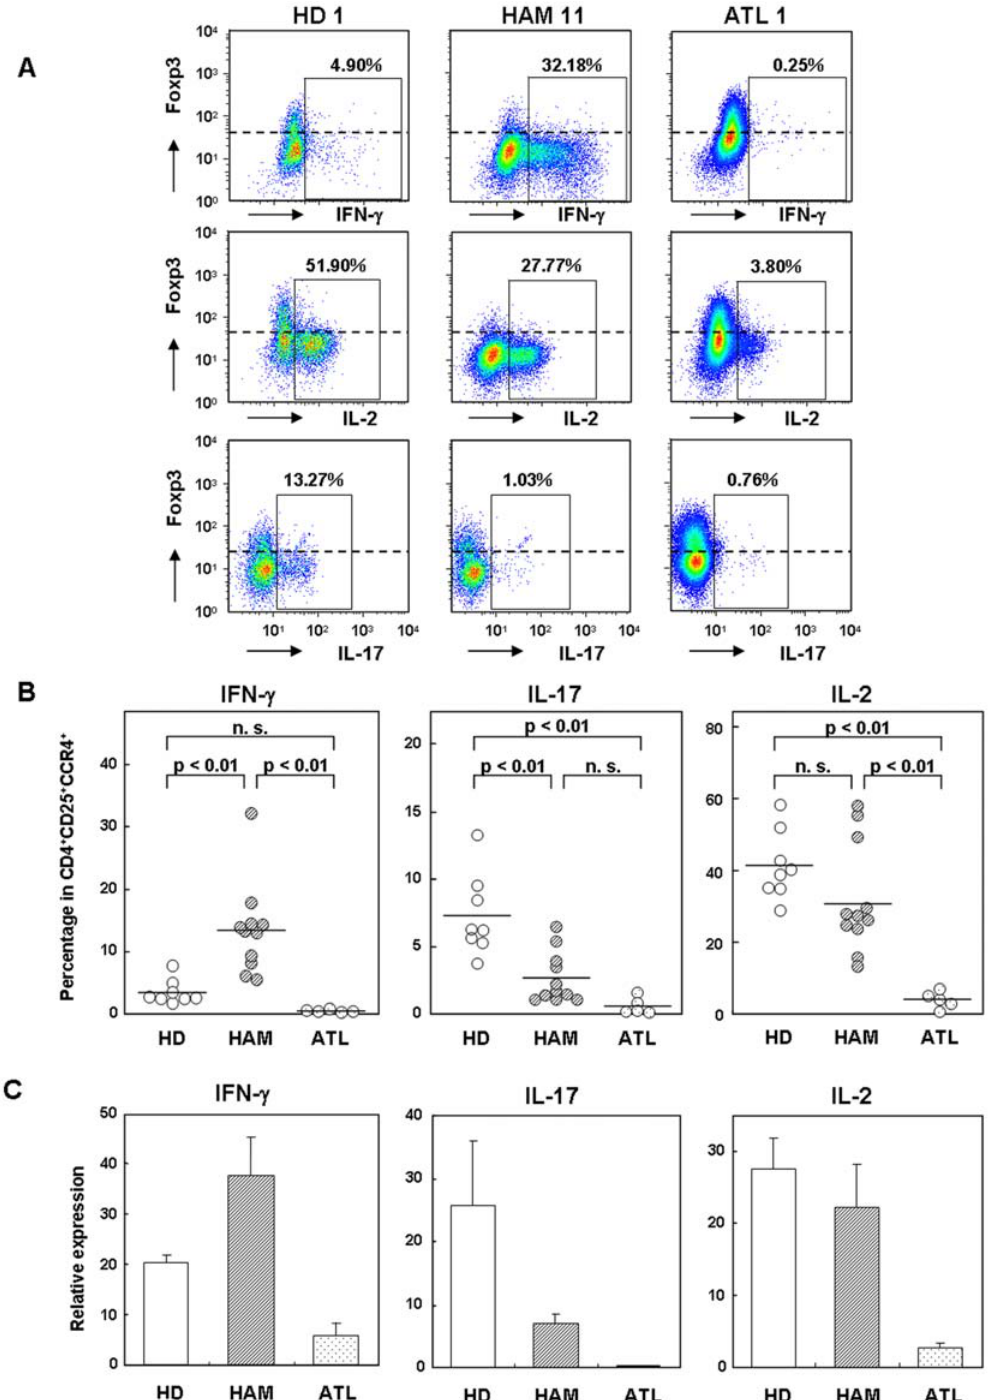
Figure 4. CD4 + CD25 + CCR4 + Foxp3 2 T cells produce multiple proinflammatory cytokines and overproduce IFN- c in HAM/TSP. A. Representative proinflammatory cytokine expression in CD4 + CD25 + CCR4 + T cells from HDs, HAM/TSP patients, and ATL patients. CD4 + T cells were negatively separated by magnetic beads, and stimulated for 5 h with PMA and ionomycin in the presence of monensin. The cells were then stained for CCR4, CD25, intracellular Foxp3, and IFN- c or IL-2 or IL-17A. The CD25 + CCR4 + cells were gated, and the expression levels of each cytokine and Foxp3 were plotted. Numbers adjacent to the outlined area indicate the percentage of cytokine-producing cells in the CD4 + CD25 + CCR4 + T cell subset. B. The percentage of proinflammatory cytokine (IFN- c , IL-17A, and IL-2) expression in CD4 + CD25 + CCR4 + T cells from 8 HDs, 11 HAM/TSP patients, and 5 ATL patients. The horizontal bar indicates the mean value of each group. Scheffe’s test (nonparametric) was used for statistical analysis. n.s. not significant. C. Real-time RT-PCR of IFN- c , IL-17A, and IL-2 mRNA in CD4 + CD25 + CCR4 + T cells separated by FACS sorting from 3 HDs, 4 HAM/TSP patients, and 3 ATL patients. Data are presented as mean 6 SE.